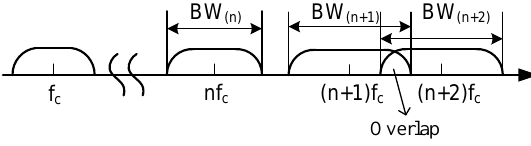
Figure 4. Sinusoidal modulation of FM square waves.